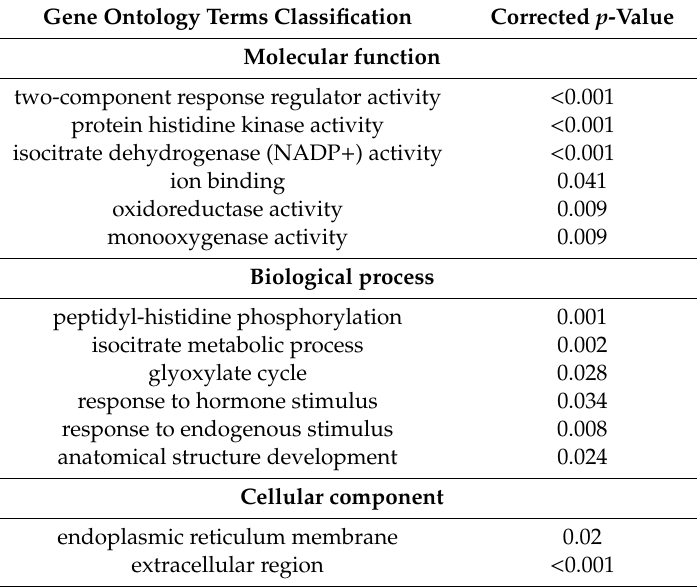
Table 1. The gene ontology of 1-MCP responsive transcripts common to MG, BR, and EO tomatoes (n = 136). Corrected p -value according to Bonferroni with cuto ff p -value < 0.05. MG—mature green, BR—breaker, EO—early